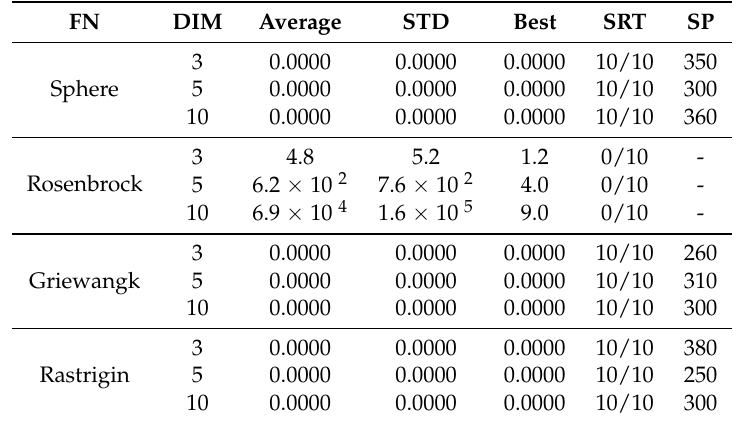
Table 1. Simulation results of the Binary Cockroach Swarm Optimization (BCSO) algorithm using the dispersion operation model of [6].